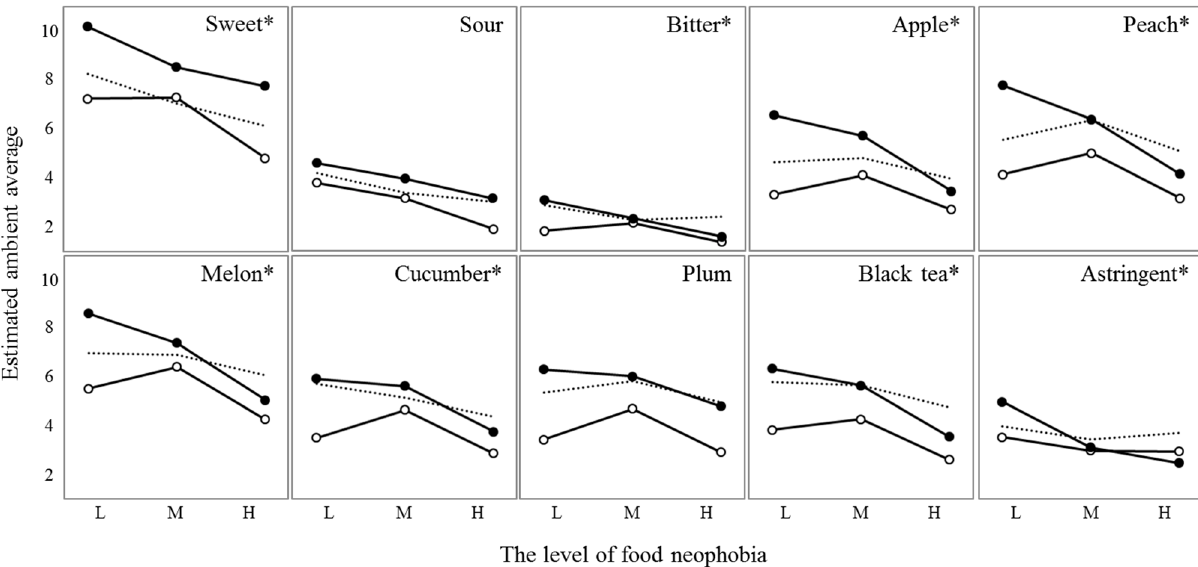
Figure 6. Plots of the interaction effects between Product involvement (low, ○ ; moderate, do tt ed line; high, ● ) and Food neophobia ( x -axis: low, L; moderate, M; high, H) for each sensory attribute. The y -axis values represent the estimated ambient averages of intensity ratings for each case. An asterisk indicates a significant interaction effect ( p < 0.05) for each sensory attribute.